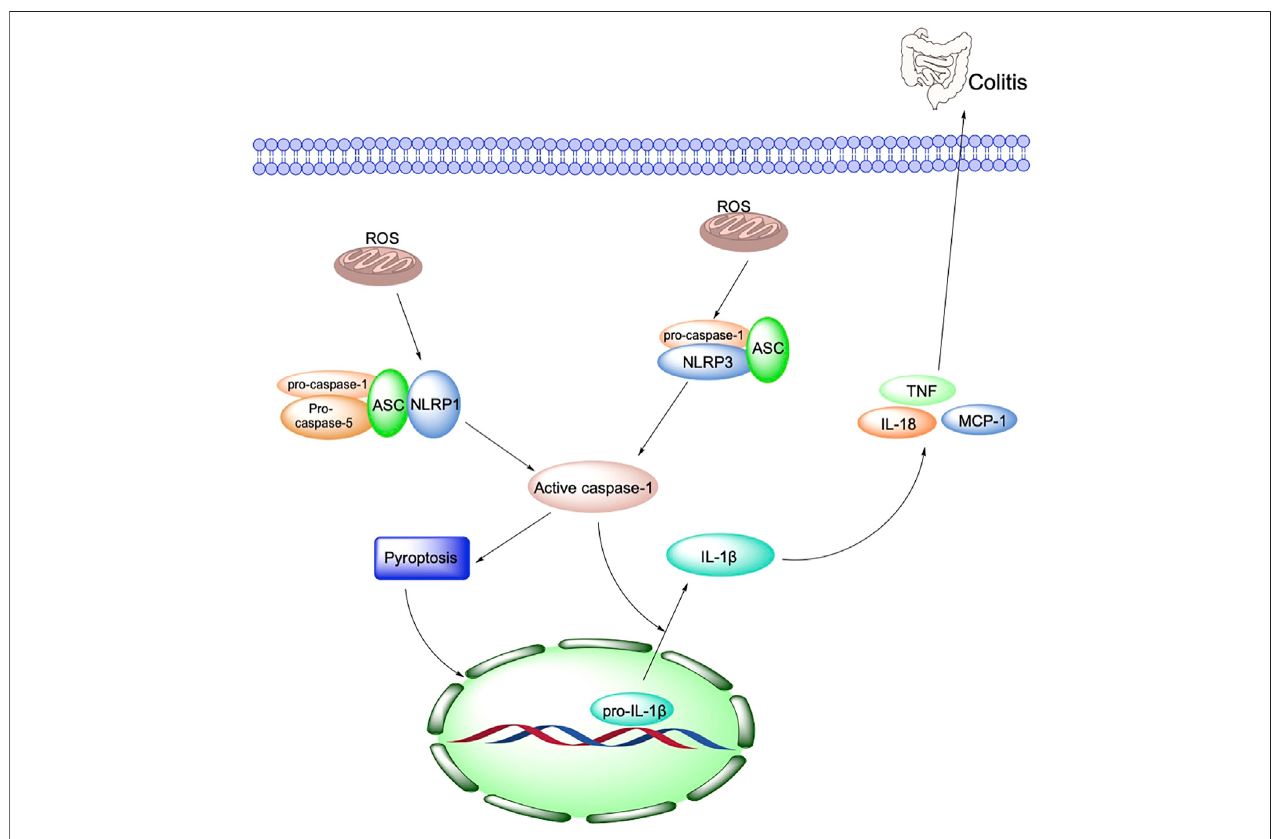
FIGURE 3 | Oxidative stress and NLRP3 are key mechanisms in the pathogenesis of IBD.